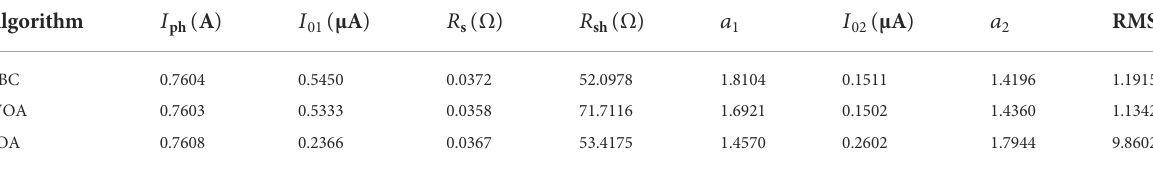
TABLE 2 Parameters identi fi cation results under DDM.